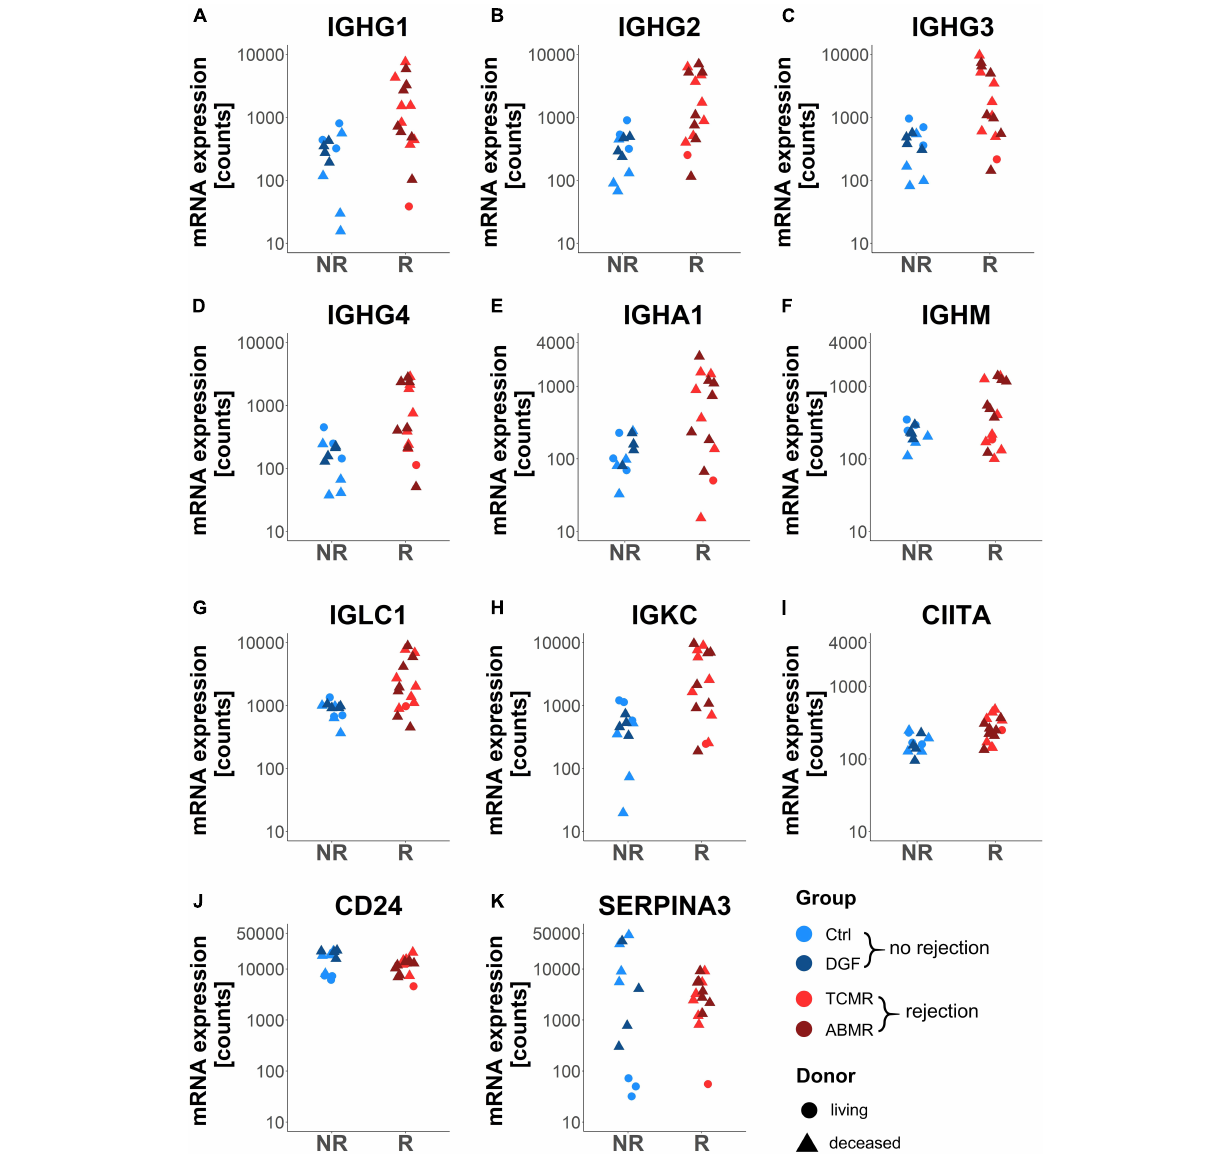
FIGURE 4 | Dot plots of genes differentially expressed in zero-time biopsies of patients later developing rejection (R) versus no rejection (NR). Dot plots showing gene expression of the genes IGHG1-4 (A–D) , IGHA1 (E) , IGHM (F) , IGLC1 (G) , IGKC (H) , CIITA (I) , CD24 (J) , and SERPINA3 (K) in zero-time biopsies. Adjusted p < 0.05 for all shown